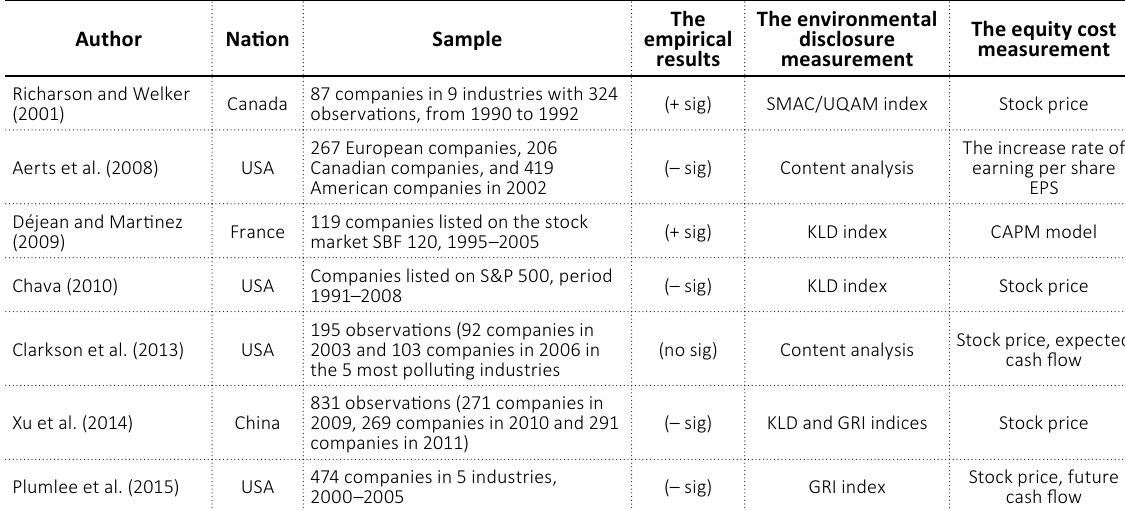
Table 1. Summary of empirical